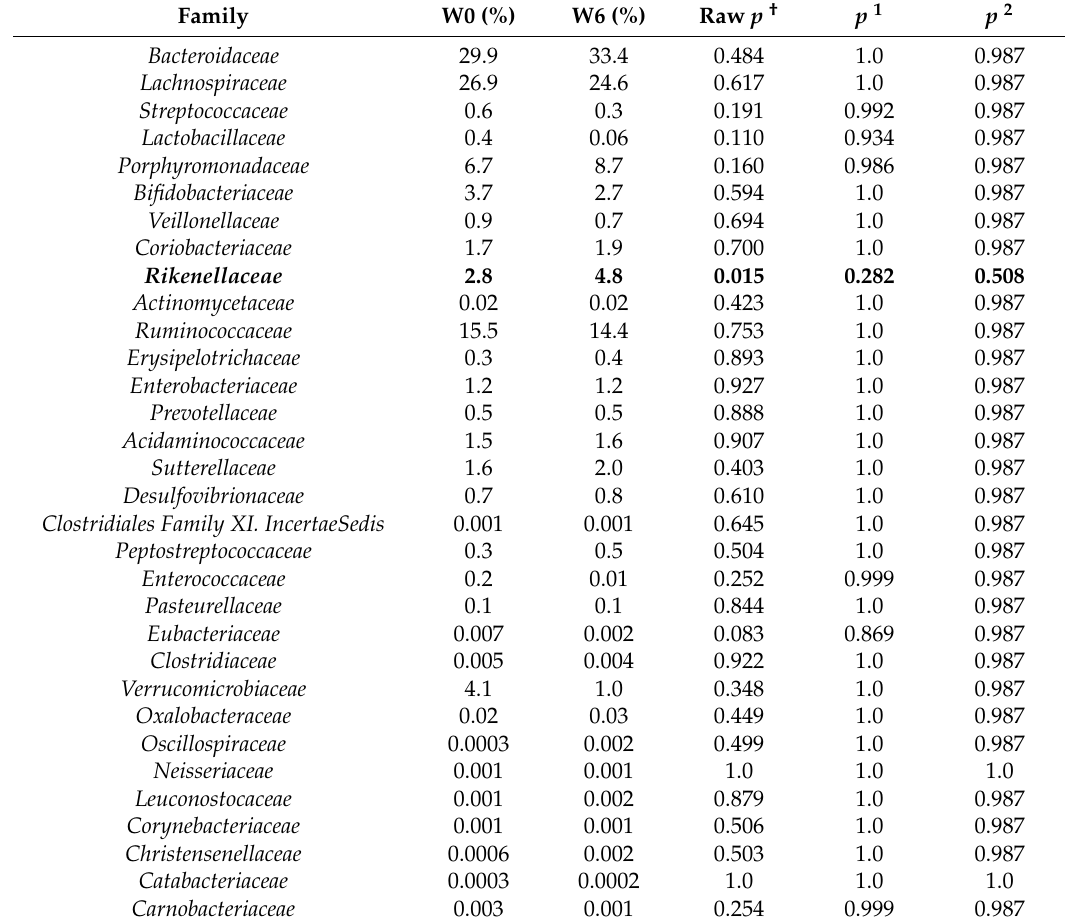
Table 6. Comparison of taxon abundance between the two time points (W0 and W6) at the level of